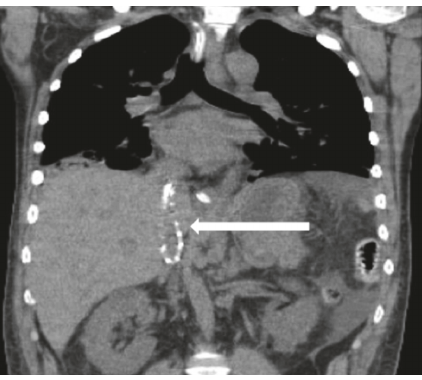
Figure 1: Evidence of retained CVC on predonation CT scan. White arrow pointing at retained CVC in IVC (coronal view).